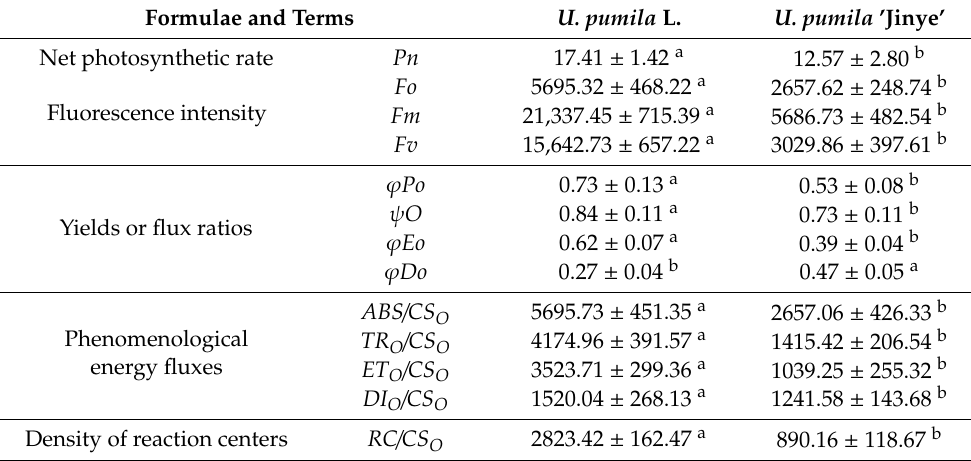
Table 1. Photosynthetic and chlorophyll fluorescence parameters.